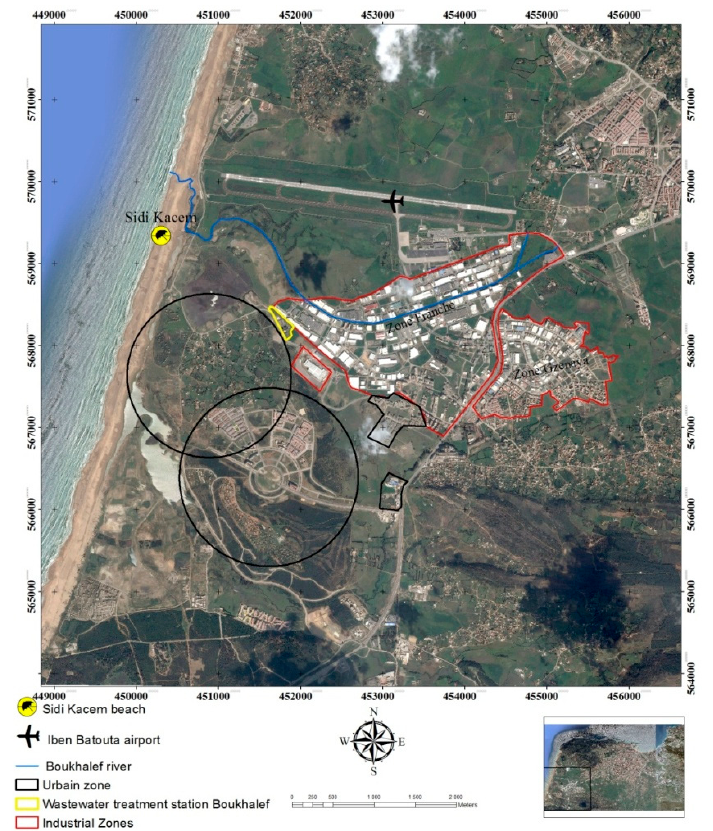
Figure 2. Map showing the two industrial zones (Tangier Free Zone (TFZ) and Gzenaya Zone (GZ)) with their surroundings. Boukhalef river mouth, Sidikacem beach and Atlantic ocean in the west, the two urban zones, Hajryine and Hassani, the Tahadart watershed in the south, the rural commune Tangier Medina in the east and the Ibn Batouta airport in the north.